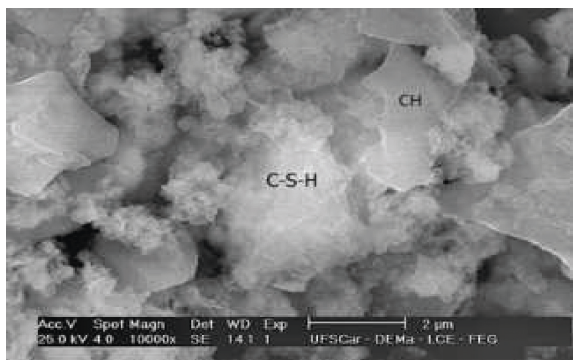
Figure 6: SEM of CSH gel for BLA calcined at 500 ° C [26].